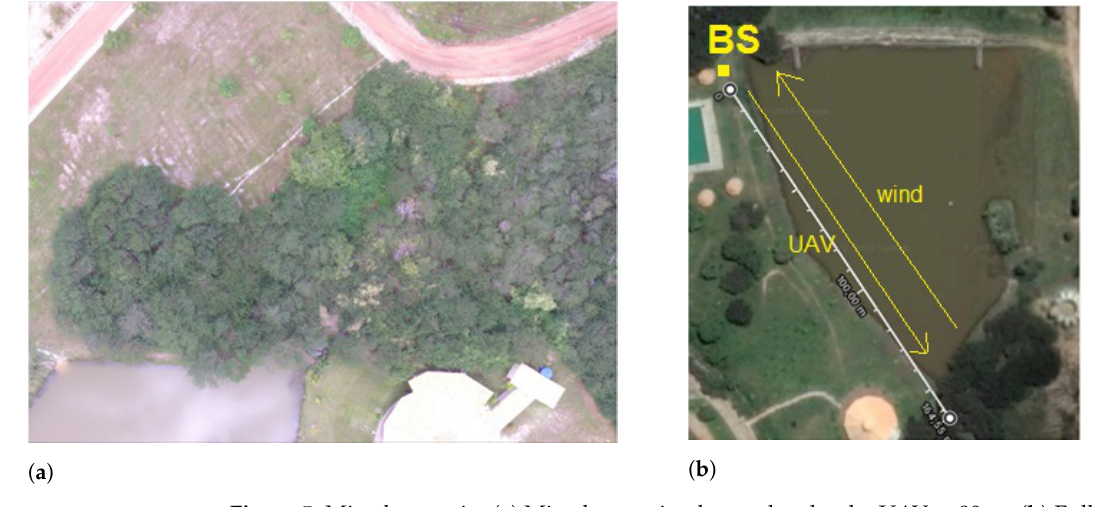
Figure 5. Mixed scenario. ( a ) Mixed scenario photo taken by the UAV at 80 m. ( b ) Full view of the mixed scenario.